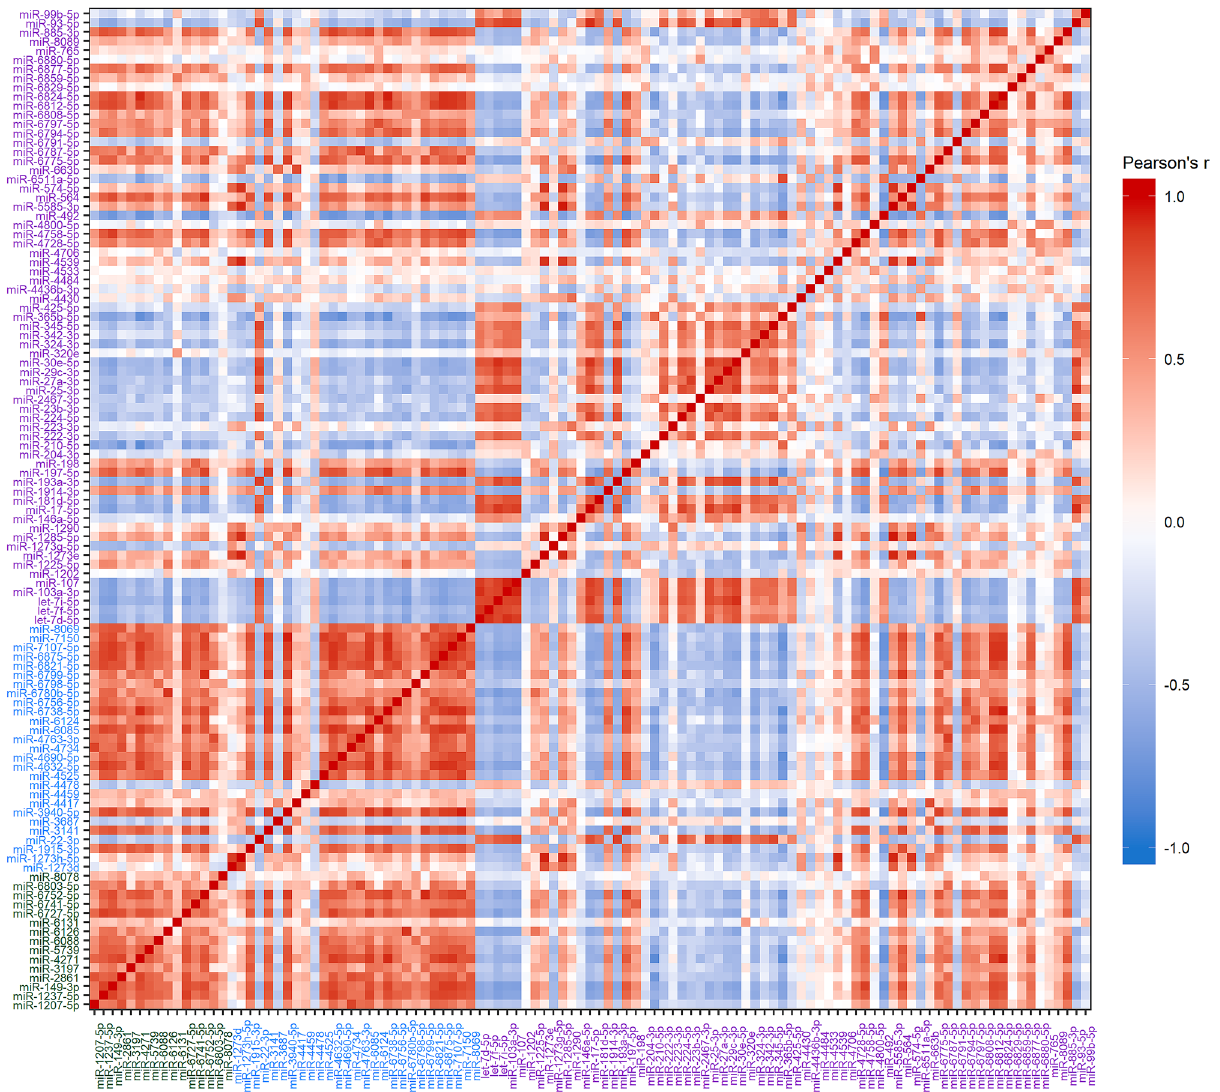
Figure 2. Pearson’s correlations between the 109 miRNAs in the top 3 clusters sorted by expression cluster membership. Gradient indicates the Pearson’s r with red indicating positive correlations and blue negative correlations. Color of label indicates original cluster membership (Green: Cluster 1; Blue: Cluster 2; Purple: Cluster